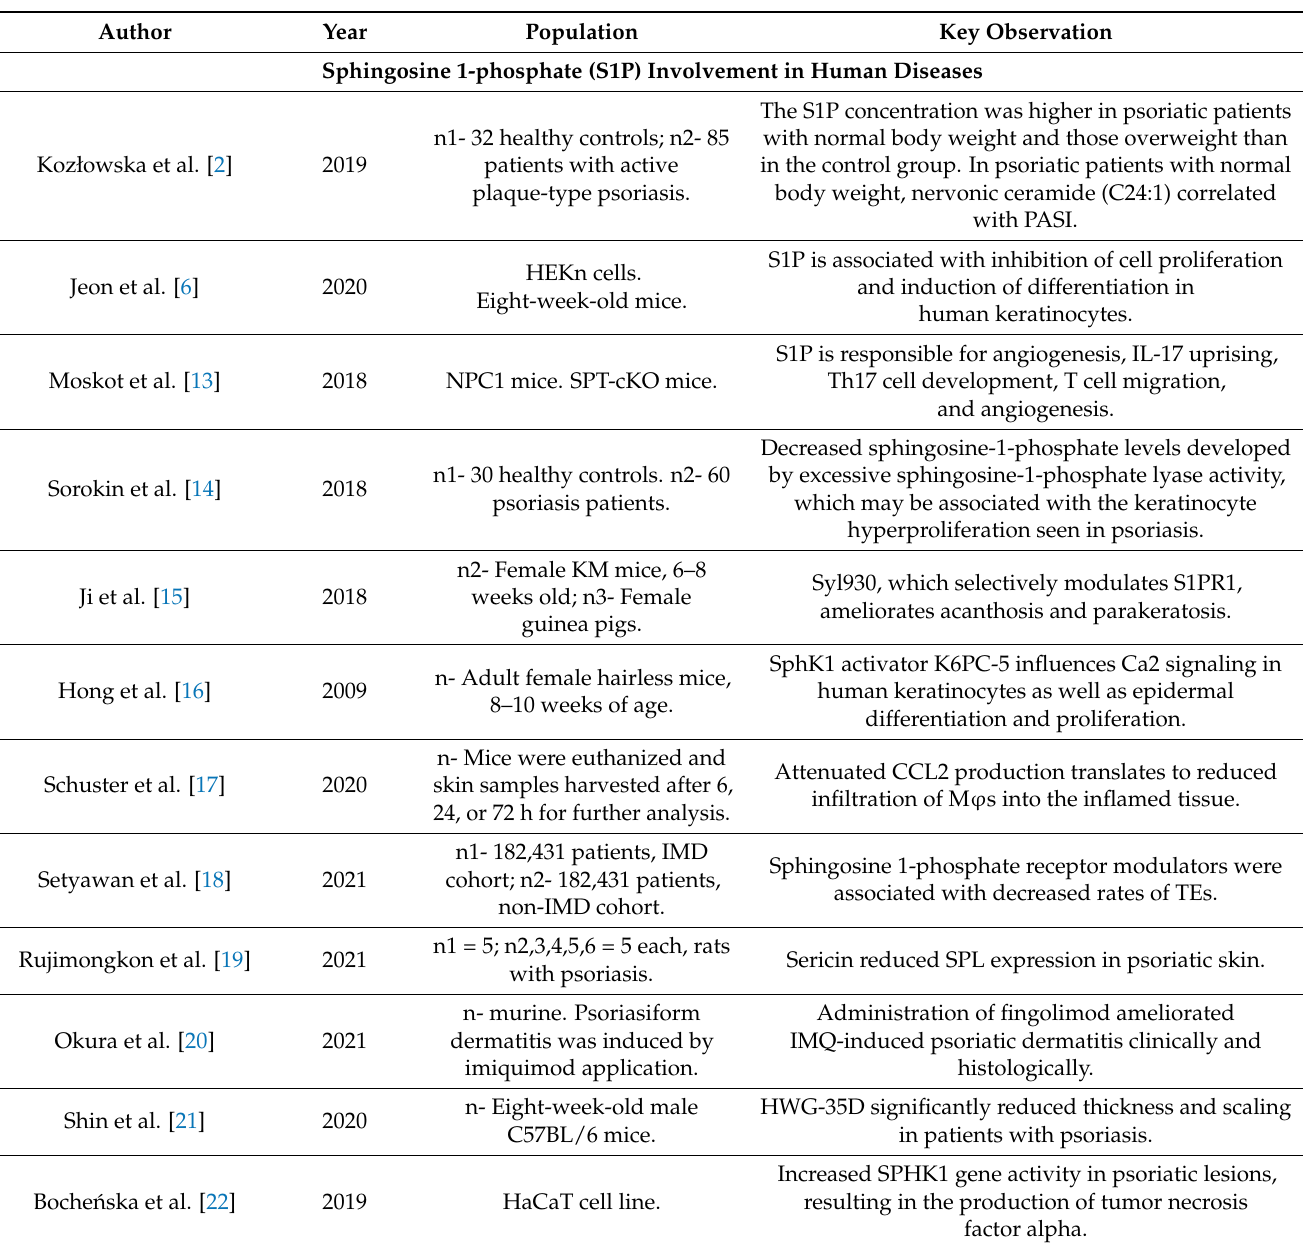
Table 2. Summary of the studies on sphingosine 1-phosphate (S1P) involvement in the pathogenesis of psoriasis.